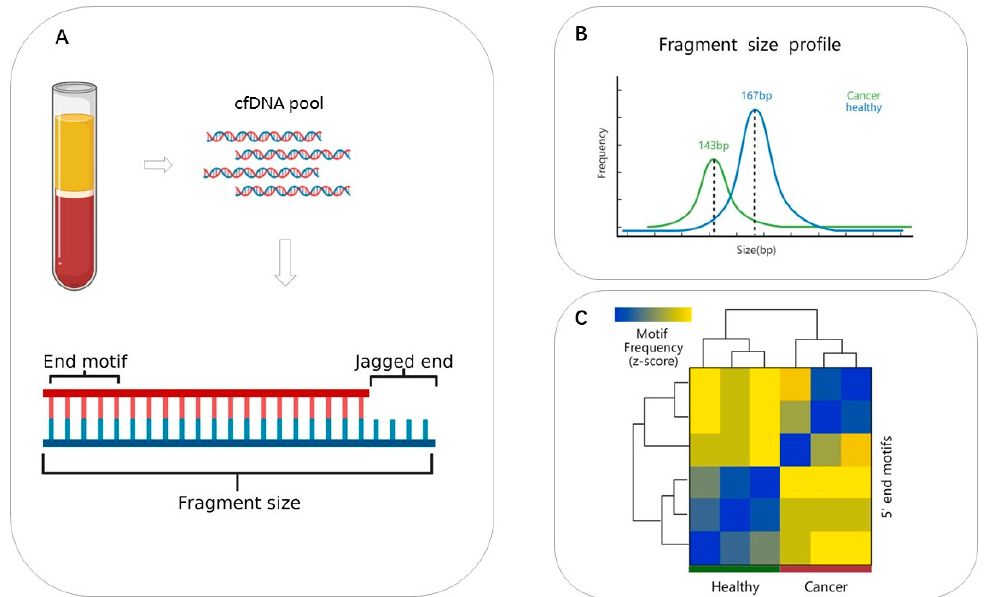
Figure 1. The characteristics of cfDNA differ in healthy individuals and individuals with cancer. ( A ) ( Top ) Different cells, including cancer cells, placental cells in pregnancy, and blood cells, contribute a cell-free DNA pool in the plasma. ( Bottom ) Sketch of cfDNA structure with fragment length, jagged ends and 4-mer end-motifs. ( B ) Overall fragment size distribution of cfDNA in cancer and normal populations. The modal size of normal individuals is 167 bp, and that of individuals with cancer is 143 bp. ( C ) Heat map analysis of 4-mer end motif frequencies between cancer and healthy individuals, which shows the end motifs of cfDNA differ in the two groups.